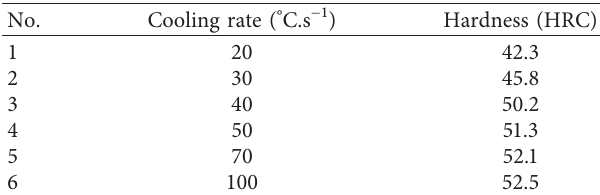
Table 4: Hardness of BR1500HS at different cooling